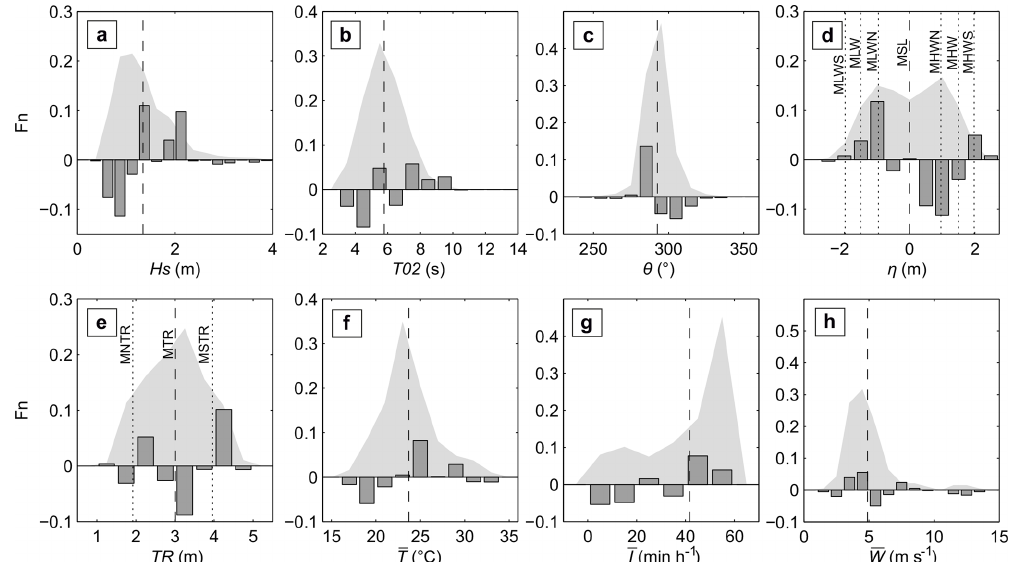
Figure 5. Environmental controls on rip-related SZIs: normalised frequency distributions, Fn , during the summers of 2007, 2009 and 2015 (light grey region), referred to as “average” background distribution, of (a) significant wave height, Hs ; (b) mean wave period, T 02; (c) wave direction, θ ; (d) water level, η ; (e) daily tide range, TR; (f) daily mean air temperature, T ; (g) daily mean hourly insolation, I ; and (h) daily mean wind speed, W , with the dark grey bars in all panels showing the difference between the surfing-related and the average background distributions and the vertical dashed line showing the background